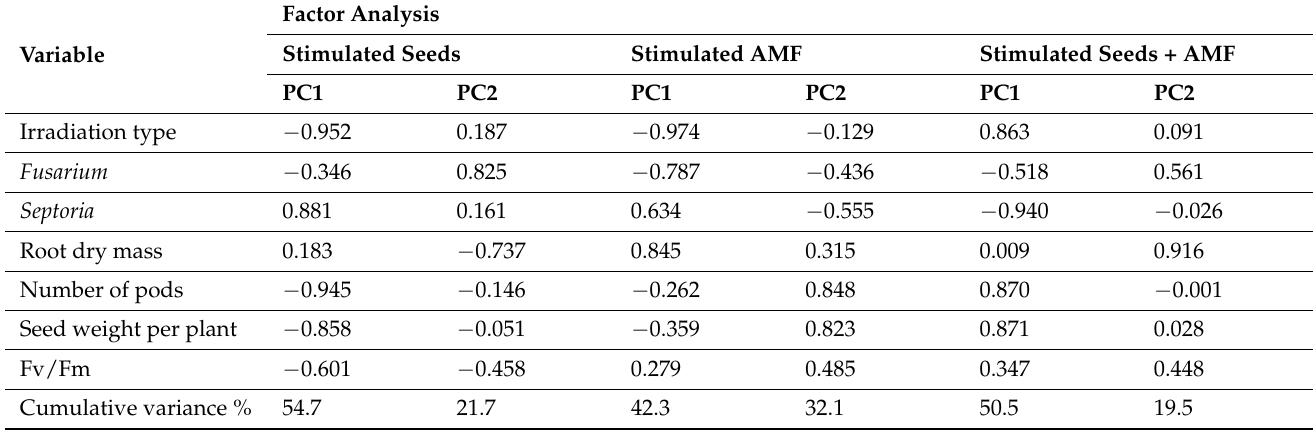
Table 4. Component matrix of the